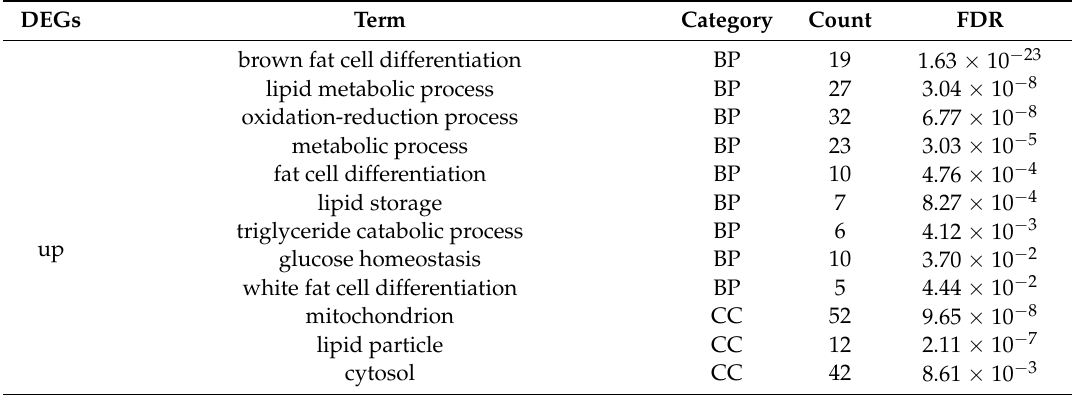
Table 3. Gene Ontology (GO) term enrichment analysis of DEGs associated with